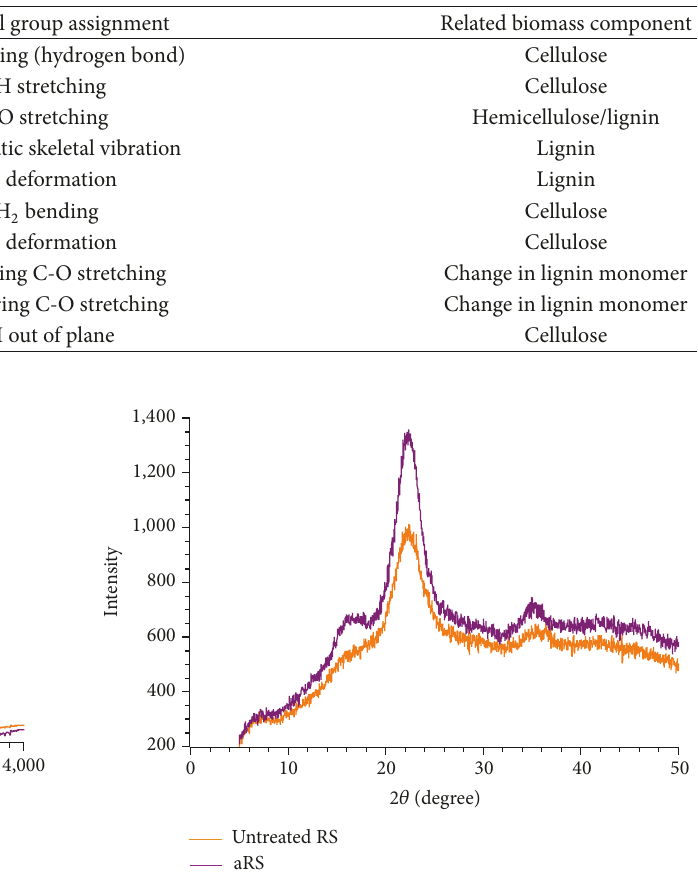
Figure 3: FTIR spectra of untreated RS and aRS. Figure 4: XRD patterns of untreated RS and